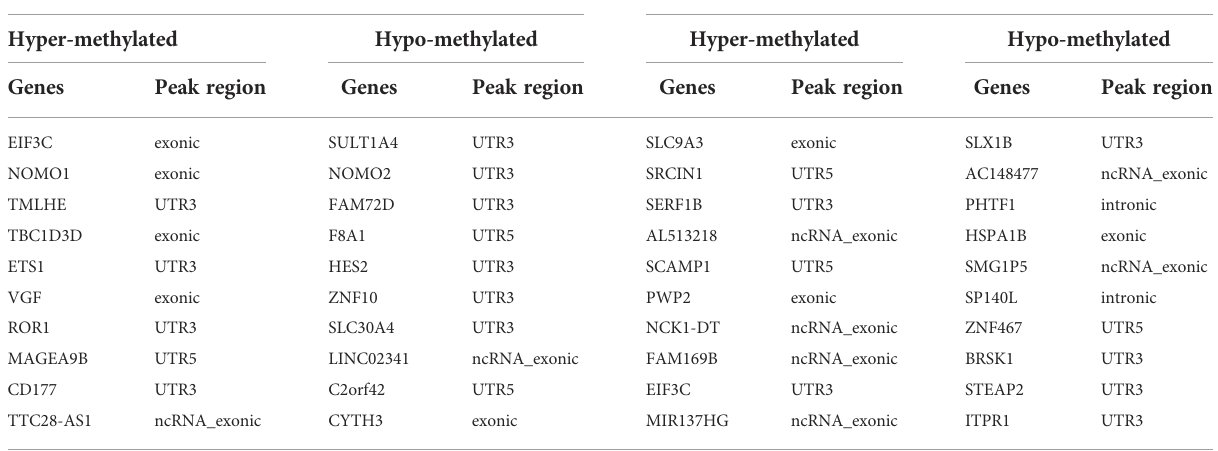
TABLE 1 The top 20 altered m 6 A peaks in DOK and SCC-9 cells compared with HOEC cells.